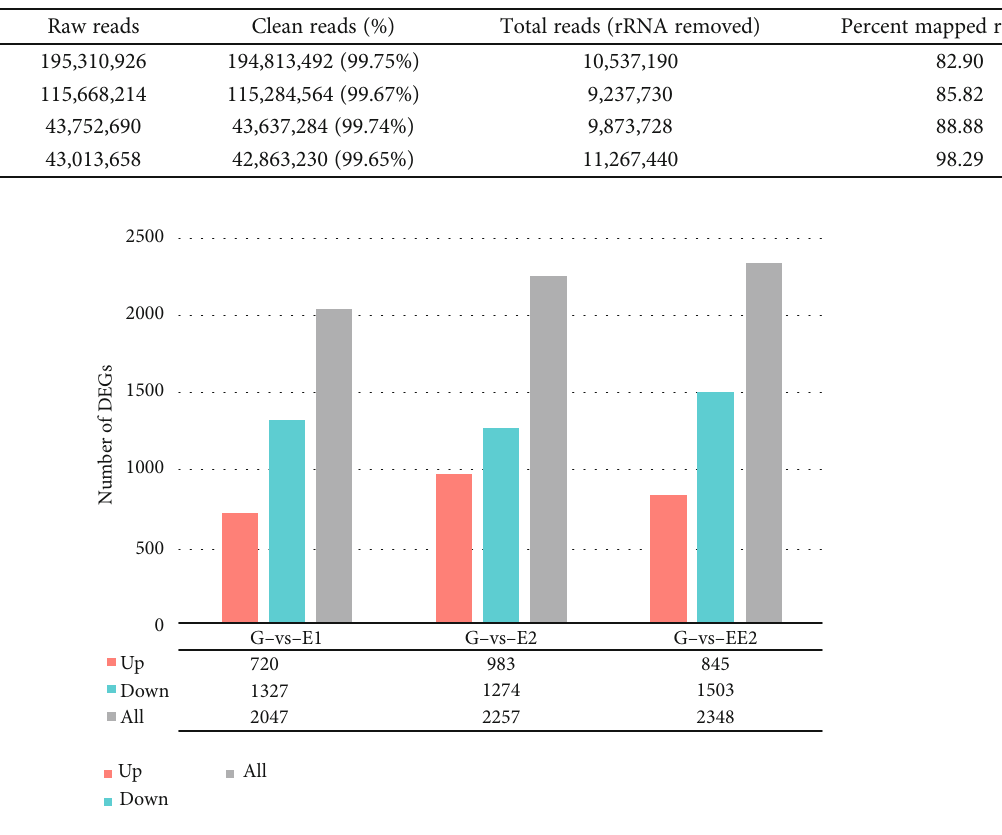
Figure 2: General overview of di ff erentially expressed genes in R-001 treated with estrogens.